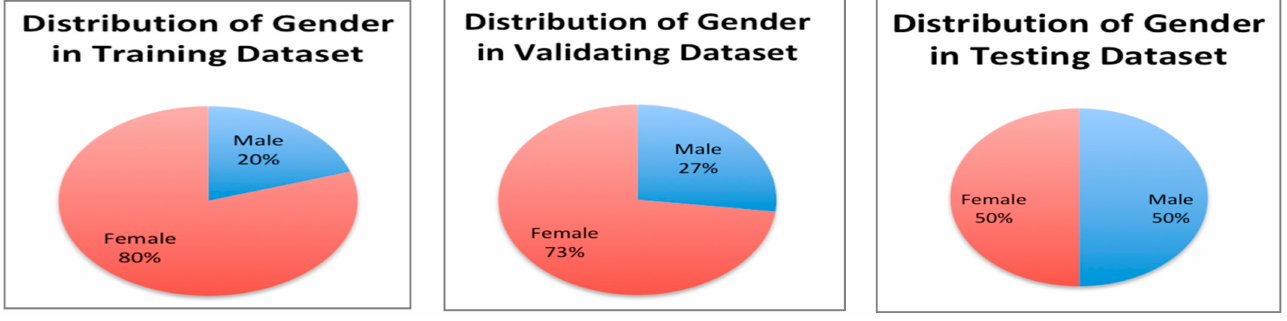
Figure 7. Dataset adjustment for phase 2.